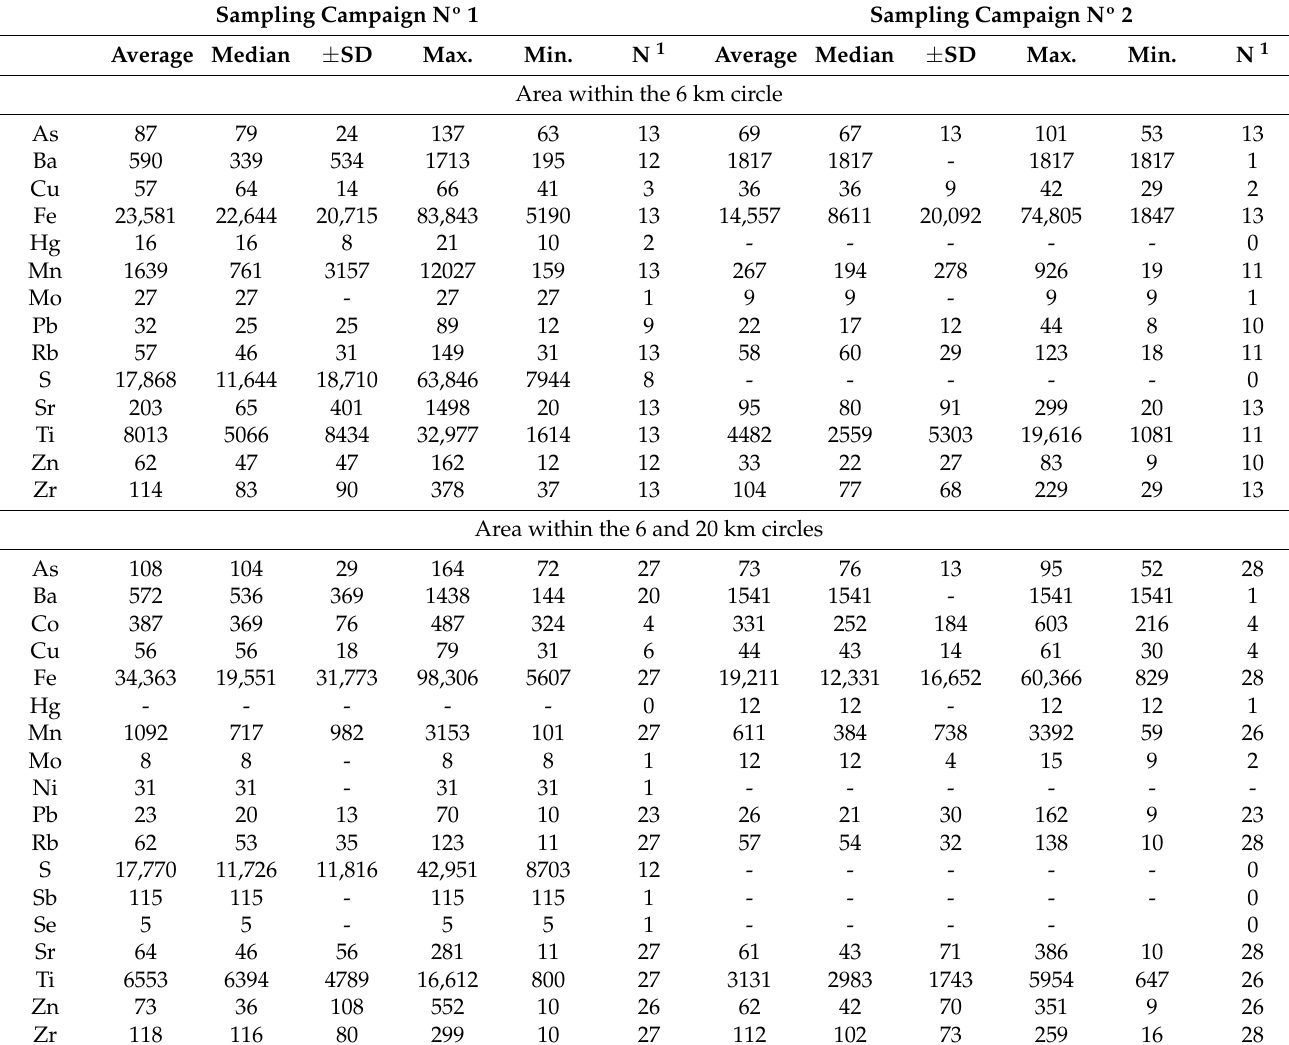
Table 6. In-situ measurements of concentration in superficial soil for selected elements